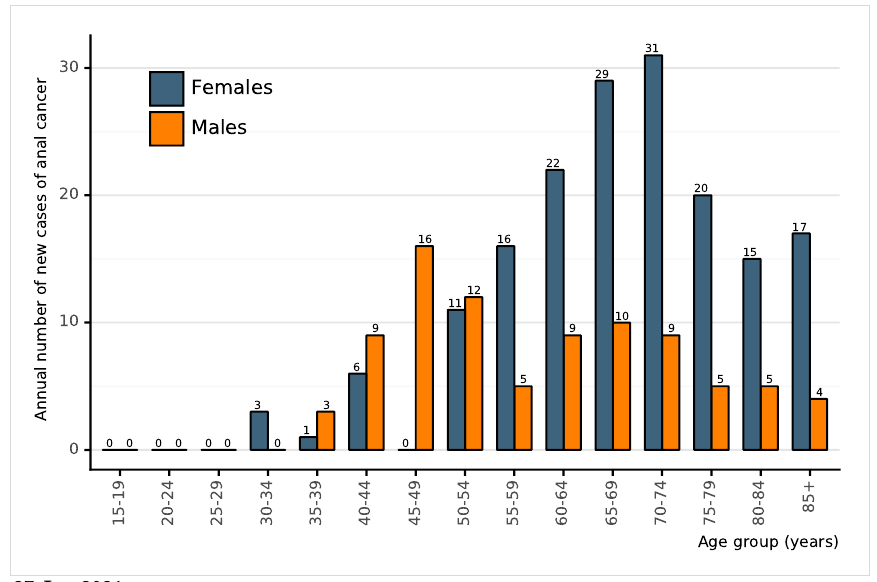
Figure 16: Annual number of new cases of anal cancer in Peru (estimates for